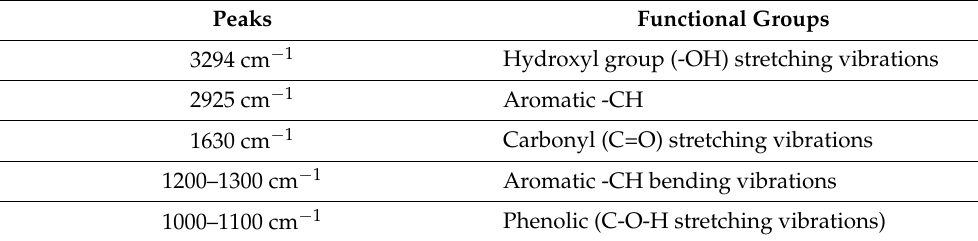
Table 3. Major FTIR peaks and associated functional groups